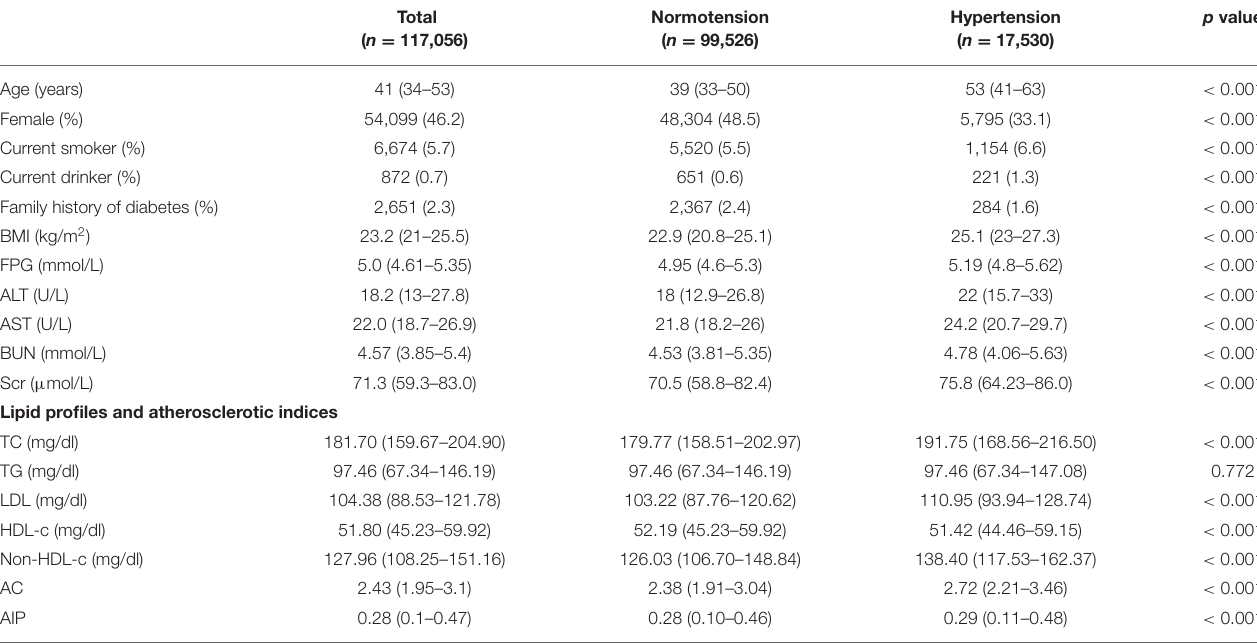
TABLE 1 | Baseline information of the overall